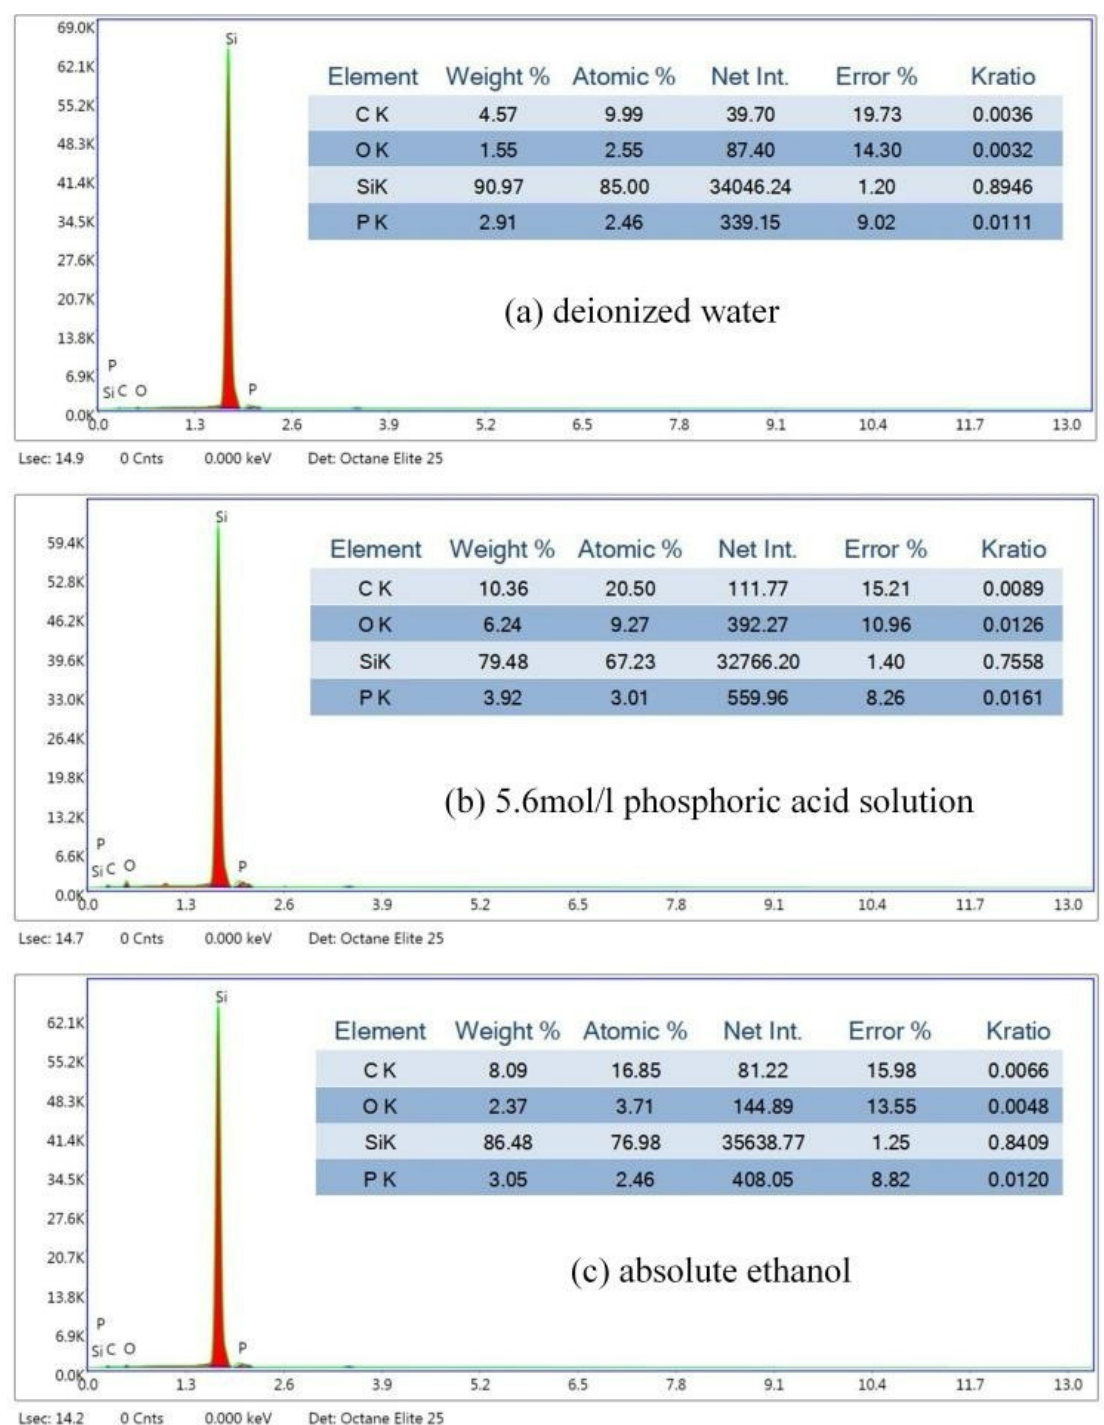
Figure 12. EDS analysis results of microchannels under different liquid